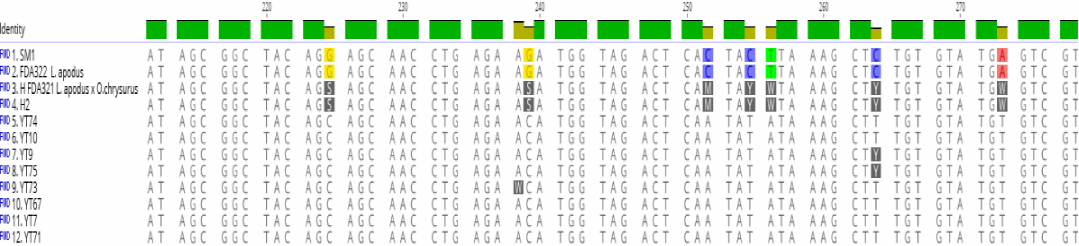
Figure 3. A portion of sequences aligned from the S7 nuclear genes of yellowtail snapper (YT), schoolmaster snapper (SM), and hybrid (H). This gene has been known to show ambiguous bases in hybrids (boxed), indicating a mixture of the parent species. In the ~322 base section from the two hybrids (Sequences 3 and 4), there were 16 instances where the hybrids showed ambiguous bases (S = C or G, M = C or A, Y = C or T, W = T or A). Each one had a base from each of the suspected parental species.